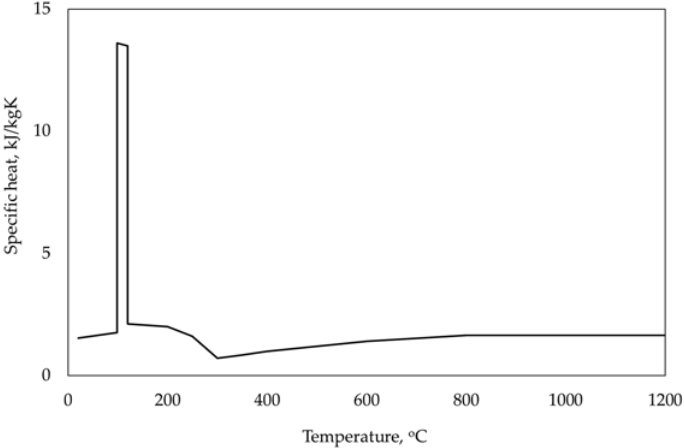
Figure 8. Thermal conductivity of wood.